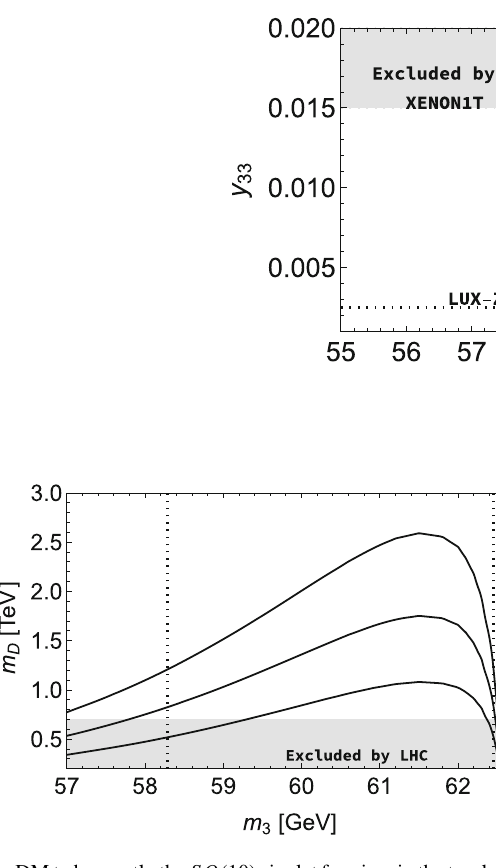
and m D . In the bottom-left panel, for the case where the DM accounts for 100% of the observed DM, we plot m D as a function of m 3 for fixed β = π/ 3 and for different choices of m [ GeV ] = 55 , 45 and 35 (solid 0 curves from top to bottom) The gray shaded region is excluded by the null LHC search results for a heavy charged lepton. The results for the case where DM accounts for only 30% of the observed DM are shown in the bottom-right panel. Its line codings are the same as those of the bottom-left